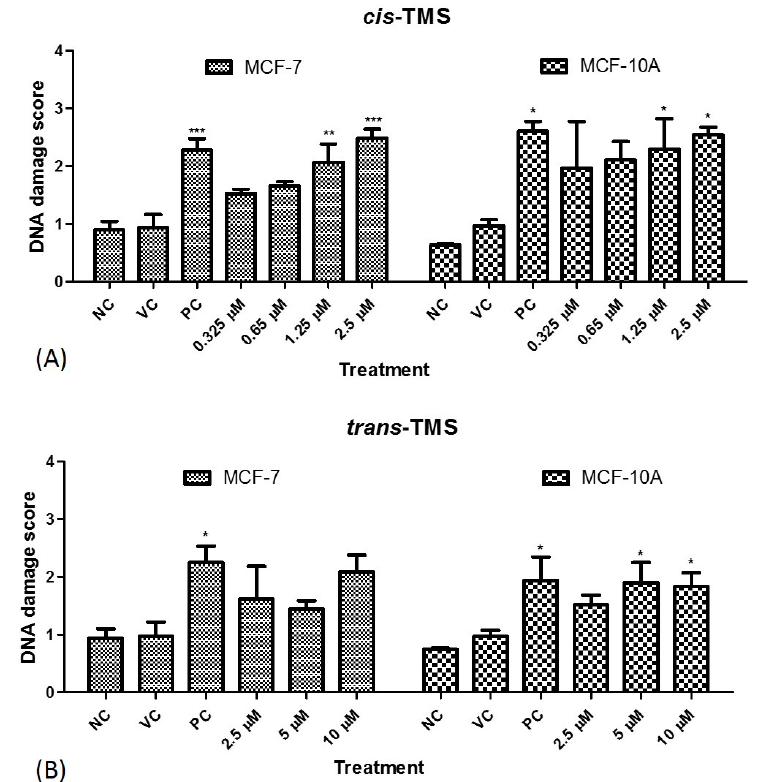
Figure 4 ‒ DNA damage obtained by comet assay in in MCF-7 and MCF-10A cells treated with different concentrations of cis - (A) or trans -TMS (B). NC: negative control; VC: vehicle control; PC: positive control; * P < 0.05 ( vs NC); ** P < 0.01 ( vs NC); *** P < 0.001 ( vs